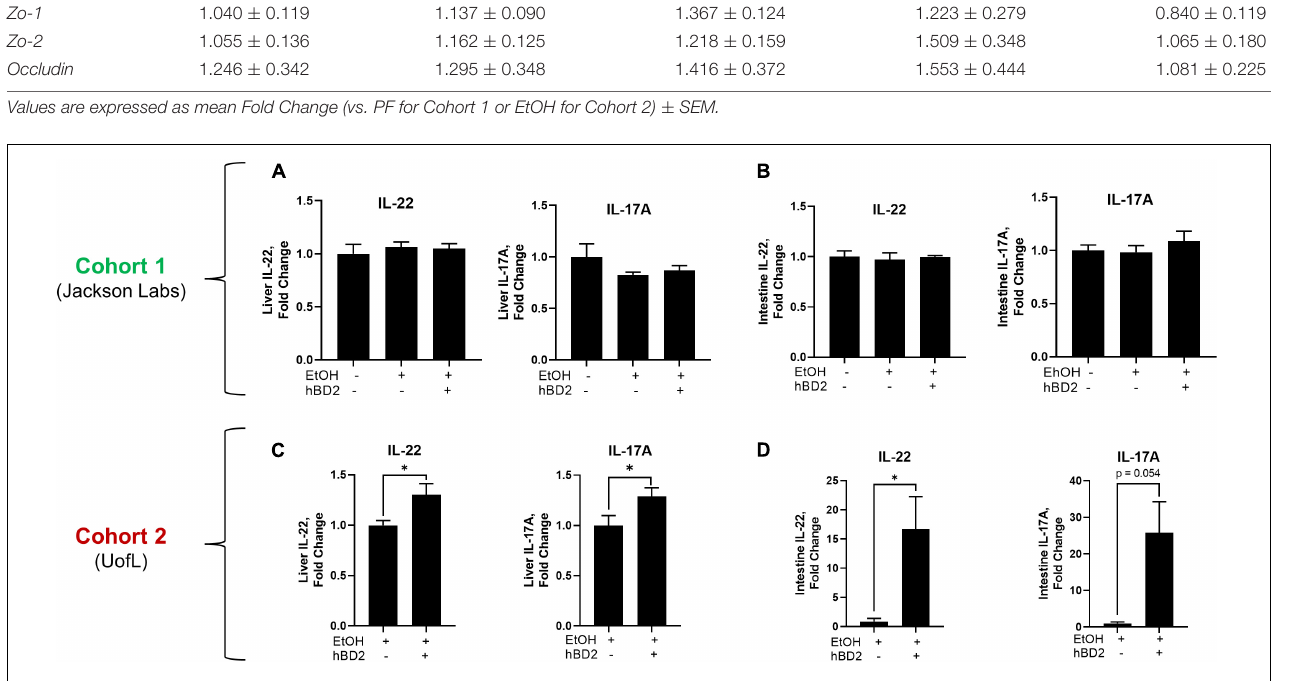
FIGURE 4 | Human beta defensin 2 altered liver and small intestine immunomodulatory cytokines. Protein levels of IL-22 and IL-17A in the liver (A,C) and small intestine tissue (B,D) of Cohort 1 and Cohort 2 mice, respectively. Data are reported as mean ± standard error of the mean. * p < 0.05.